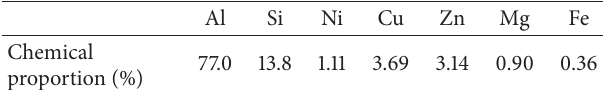
Table 1: Chemical proportion of aluminum alloy (in wt%). Al